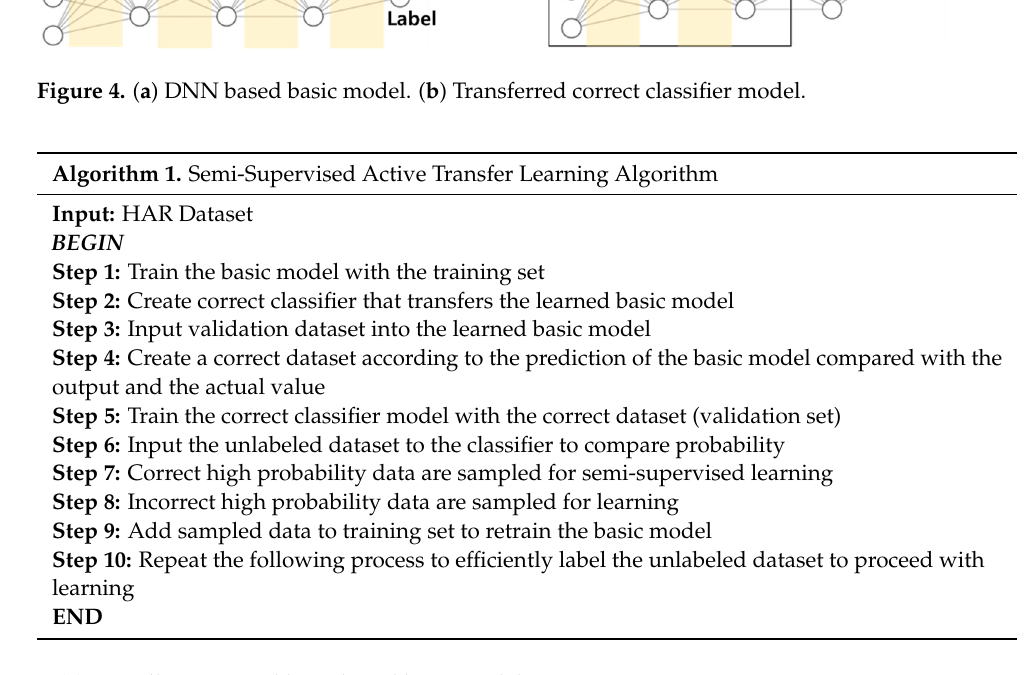
Table 4. Fully connected layer based basic model.